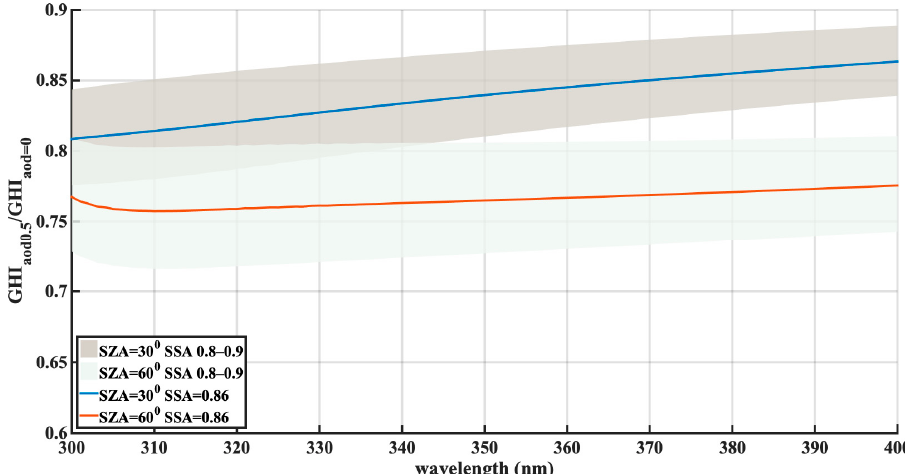
Figure 9. Ratio of modeled spectra in the UV region, as derived from RTM, with mean AOD measured by BRS on 14 May 2020 and no aerosols, at two solar zenith angles. The range of the ratios for different runs with SSA between 0.9 and 0.8 is shown.